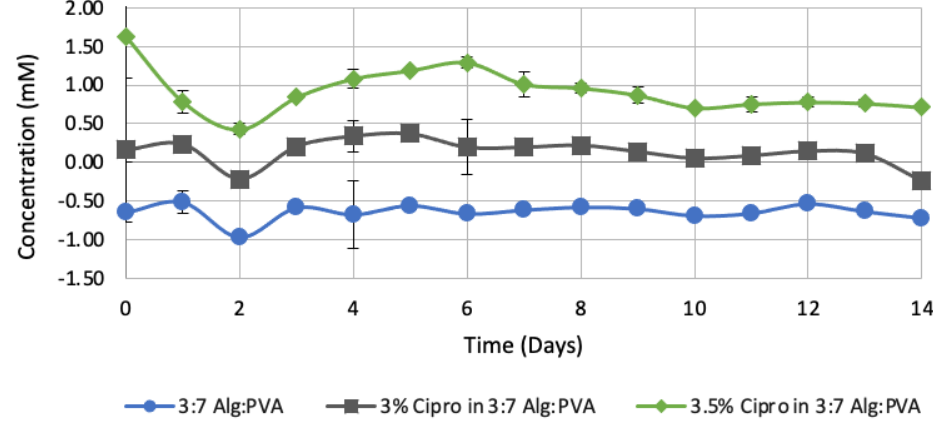
Figure 9. Comparison of average ciprofloxacin release over 14 days from 3–3.5% ( w/v ) Cipro-loaded 3:7 2.5% Alg:10% PVA nanofibers and control, non-loaded 3:7 2.5% Alg:10% PVA nanofibers ( n = 3, p ≤ 0.001). All fiber scaffolds were 1.5 cm × 1.5 cm. A standard deviation for each time point is